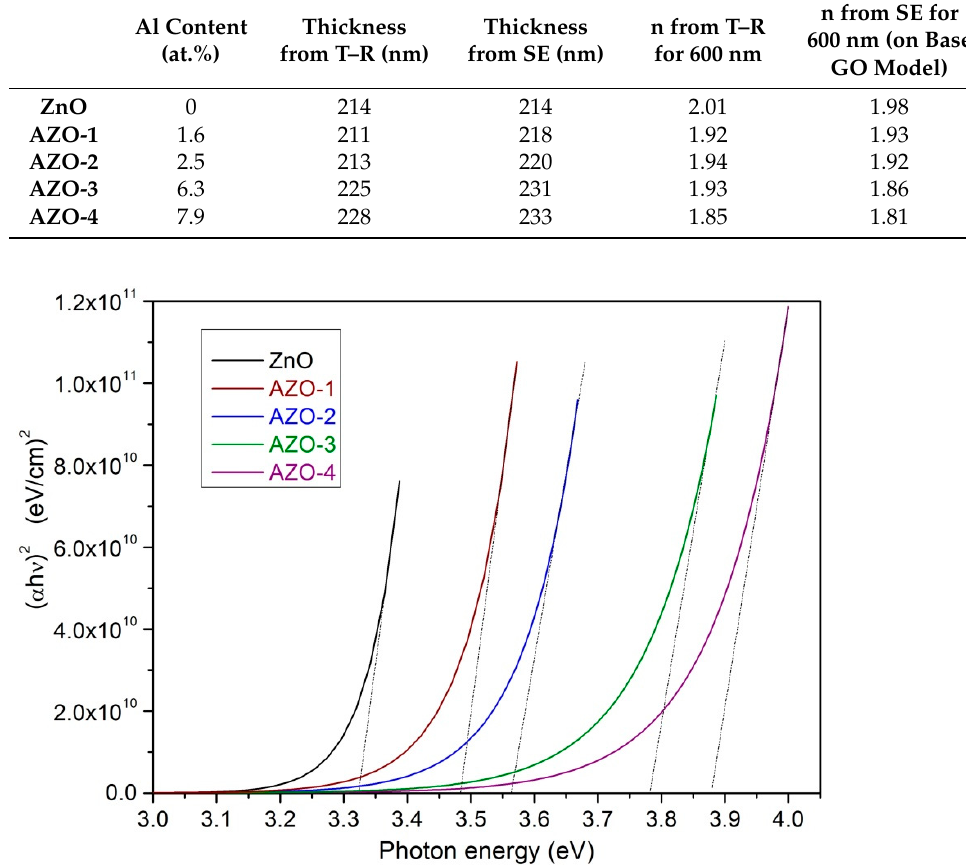
Figure 11. Energy gap for analyzed thin films, detected from Formula